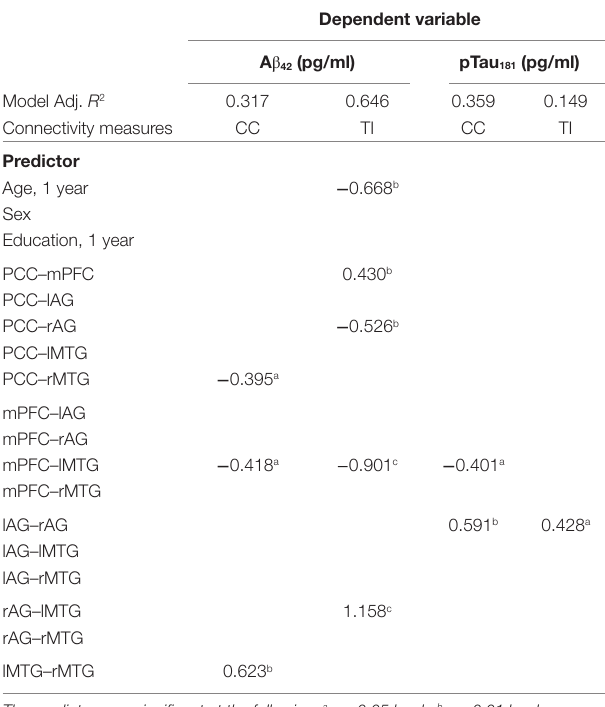
TaBle 3 | standardized beta coefficients for a β 42 and pTau 181 models, including task-driven fMri functional connectivity measures [cross- correlation (cc) and total interdependence